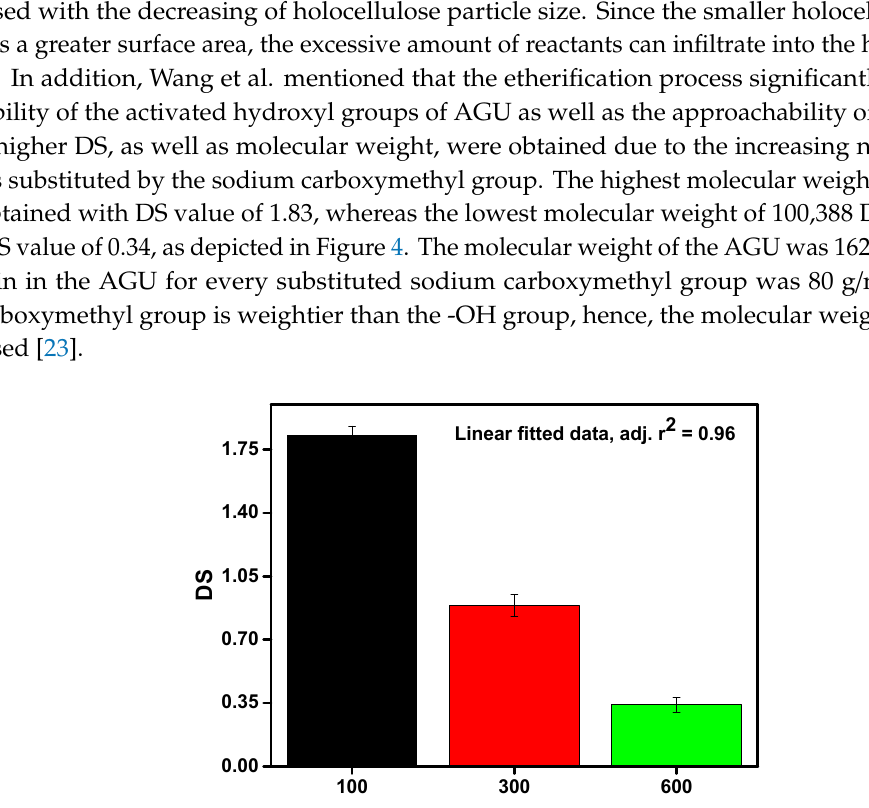
Table 1. Composition of corn waste residue (Each test was performed at least three times and average and standard deviation were considered).